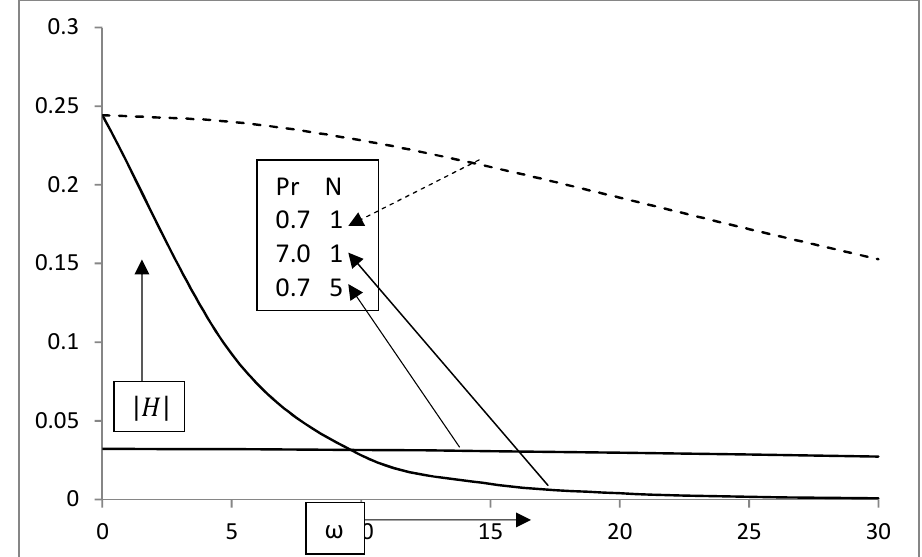
Figure 6. Amplitude of Nusselt number .